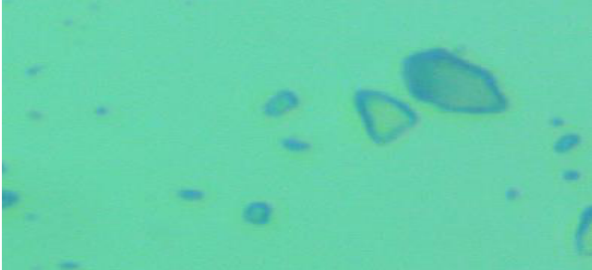
Fig. 1. Micrographs of metronidazole gel benzoate,